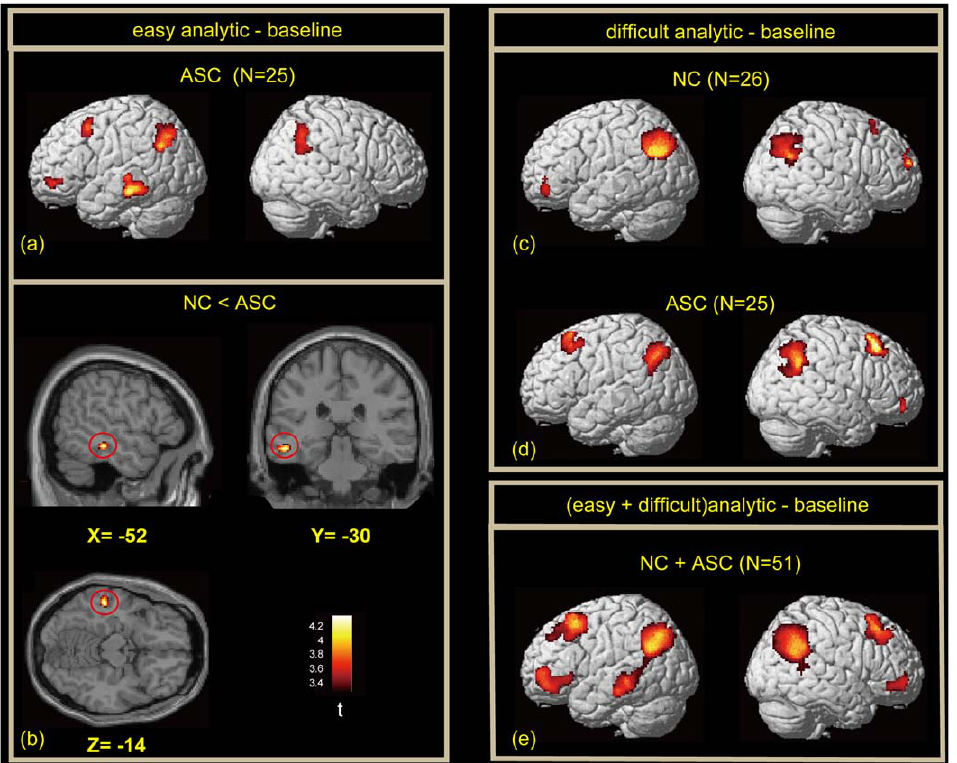
Figure 3. Lateral surface rendering of activation during the easy, difficult, and (easy + difficult) analytic conditions. (a) Participants with autism spectrum condition (ASC) during the easy analytic condition. Normal control (NC) showed no significant activation during the easy analytic condition. (b) Direct comparison between NC and ASC (NC , ASC) during easy analytic condition. (c) NC during the difficult analytic condition. (d) ASC during the difficult analytic condition. (e) Combined analysis of the two groups during the two analytic conditions. Statistical threshold was set at p , 0.001, uncorrected for multiple comparisons. Spatial extent threshold was k . 72 voxels. doi:10.1371/journal.pone.0043220.g003 figural (baseline), easy analytic, and difficult analytic conditions separately. For each condition, we first created r- and z-maps in each participant following the same procedures described above Table 3. Significant activity during easy analytic except that the number of data points was 60 (12 points 6 5 blocks), 24 (12 points 6 2 blocks), and 24 (12 points 6 2 blocks) for figural (baseline), easy analytical, and difficult analytical conditions, respectively. The first three data points were removed to exclude signal fluctuations due to block transition [31,32], which resulted in 12 data points in each block. We then extracted mean z-values from the cube of 27 voxels centering the voxel showing the highest t-value within a significant voxel cluster identified in the group comparison. Finally, we performed a two-way ANOVA of Condition (figural, easy analytical, and difficult analytical) x Group (NC and ASC) for that cluster.